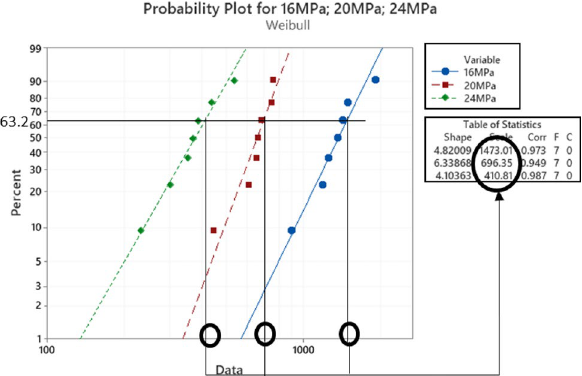
Figure 3. The Weibull probability plots for SAC305 solder joints cycled at room temperature and at different load levels (reused and modified from) 30